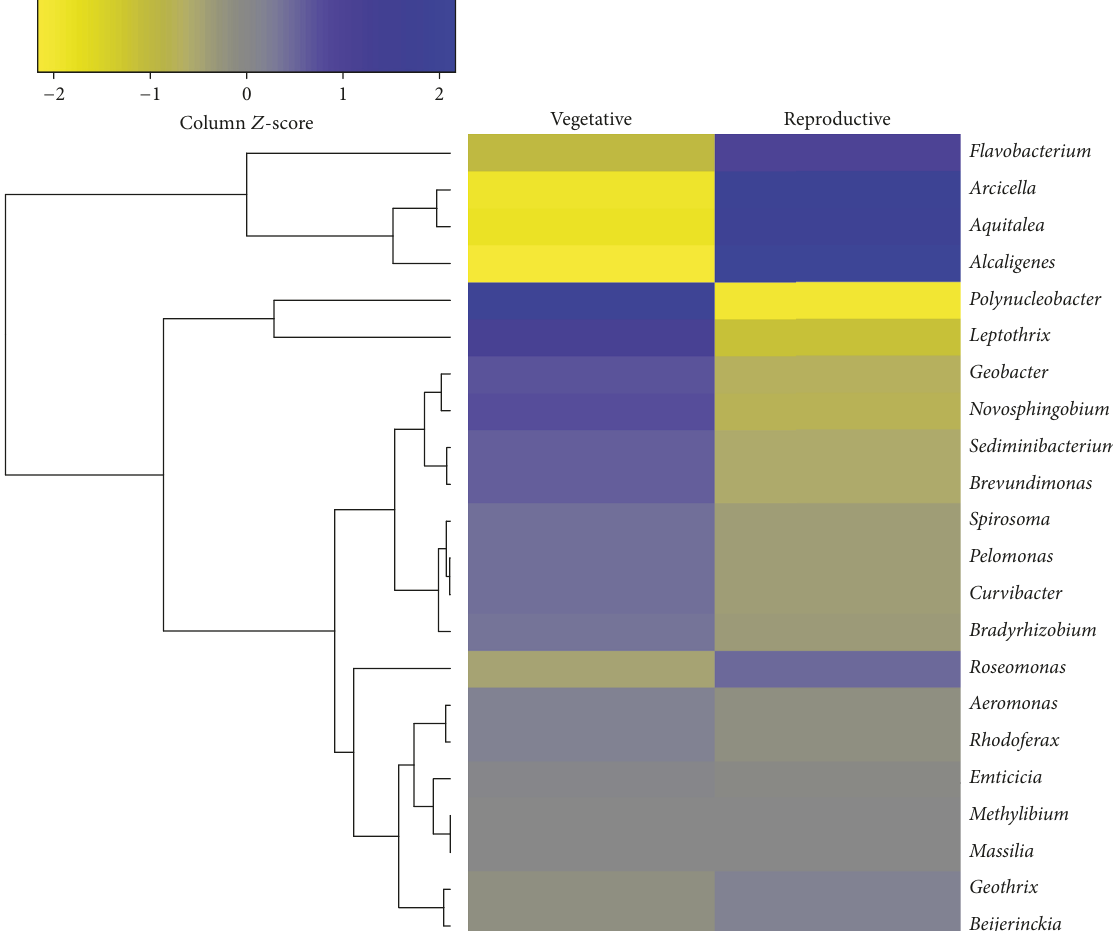
Figure 5: Heatmap and correlation analysis of the 22 bacterial genera found in both the vegetative and reproductive stages of flooded rice. The relative abundances of these genera in floodwaters associated with each developmental stage were log 2 transformed, scaled by 𝑧 -score, and used for clustering and heatmap analysis. Color intensity is correlated with the relative abundance of each genus in floodwaters associated with the two developmental stages, with blue indicating higher relative abundance and yellow indicating lower relative abundance.